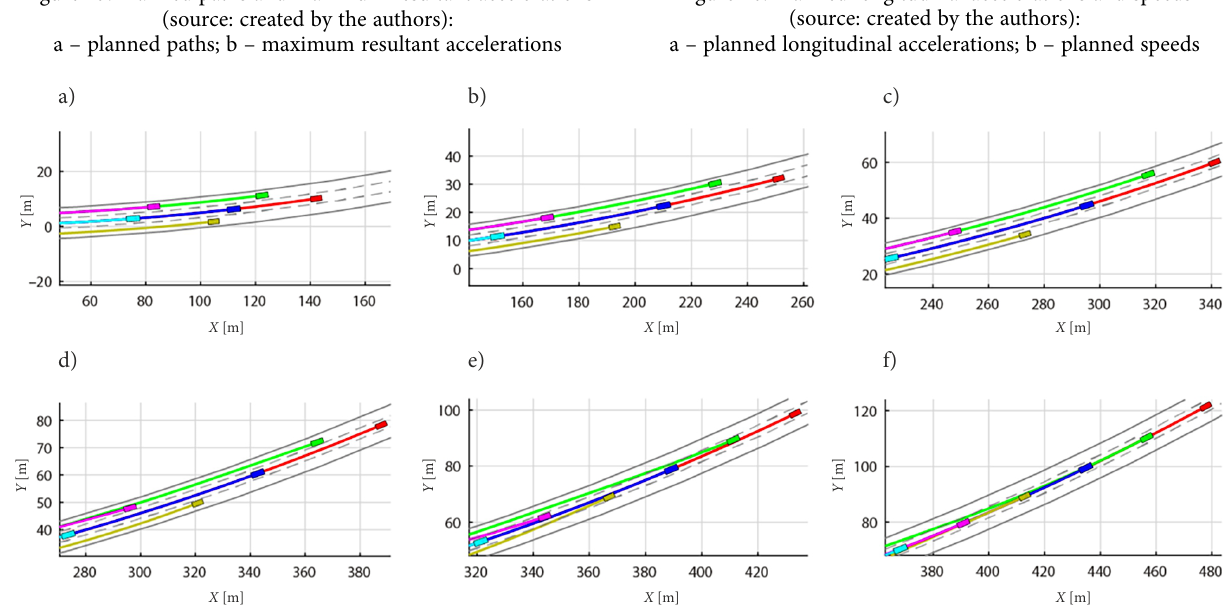
Figure 17. Camera shots of merging control (source: created by the